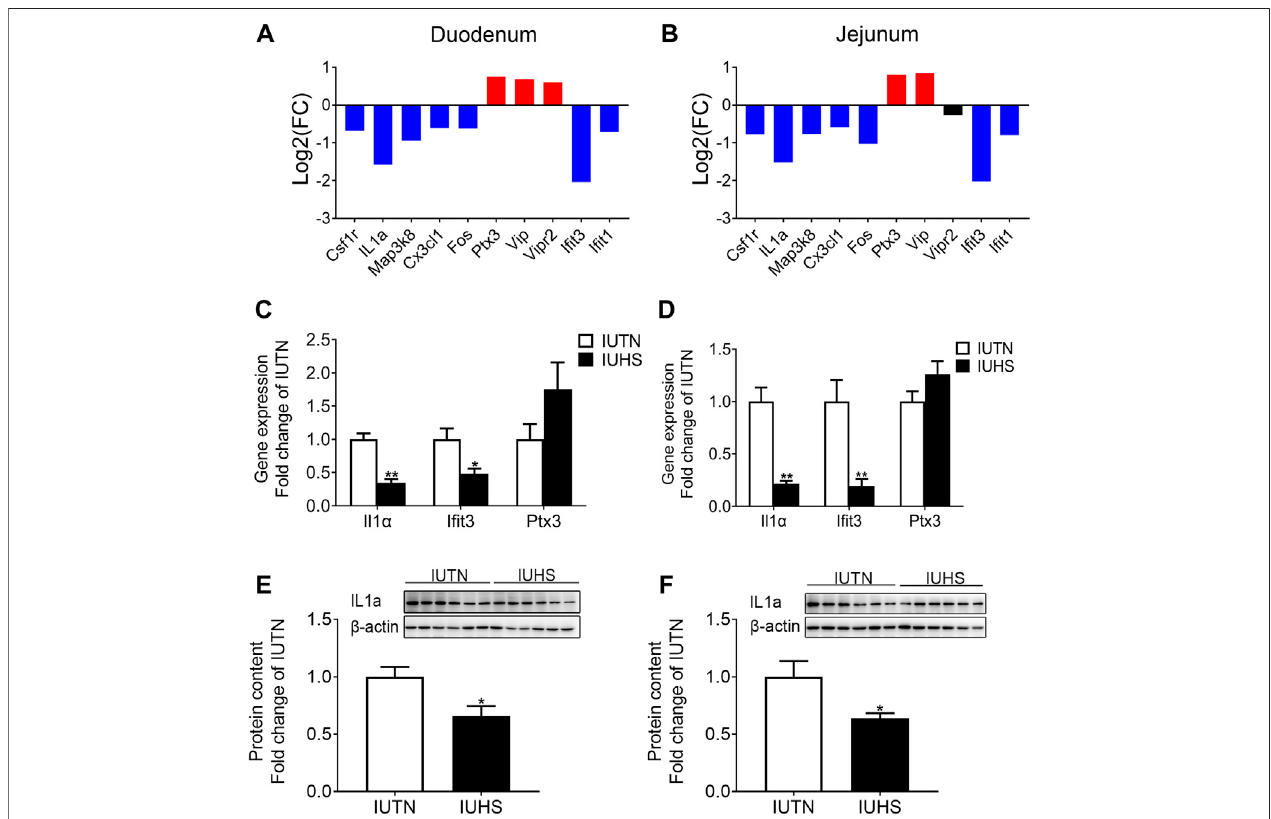
FIGURE 6 | Effects of maternal HS on the innate immune development in the fetal duodenum and jejunum. Fold change of DEGs (A) , mRNA expression (C) , and protein levels(IUTN: n =8;IUHS: n = 5) (E) in thefetalduodenum.Fold changeofDEGs (B) , mRNAexpression (D) , and protein levels(IUTN: n =8;IUHS: n =5) (F) inthe fetaljejunum.Genesymbolsareshownonthex-axis,andlog 2 FCisshownonthey-axis.Bluebars:down-regulation; redbars:up-regulation.Black:nodifference.Data are presented as mean ± SEM. * p < 0.05, ** p < 0.01.